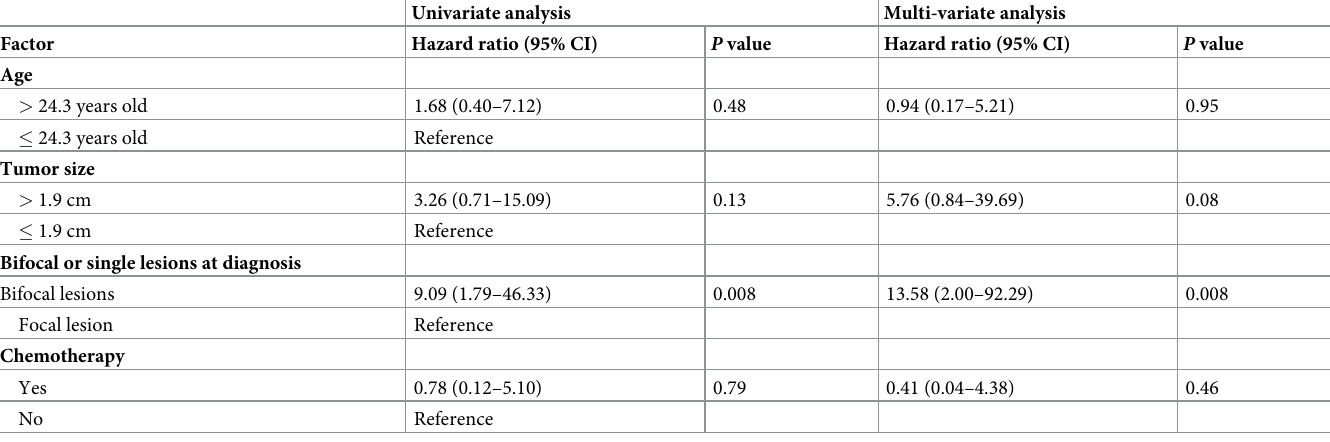
Table 3. The hazard ratio and P value of each factor in single variate and multi-variate Cox model for disease recurrence in adolescent and young adult germinoma